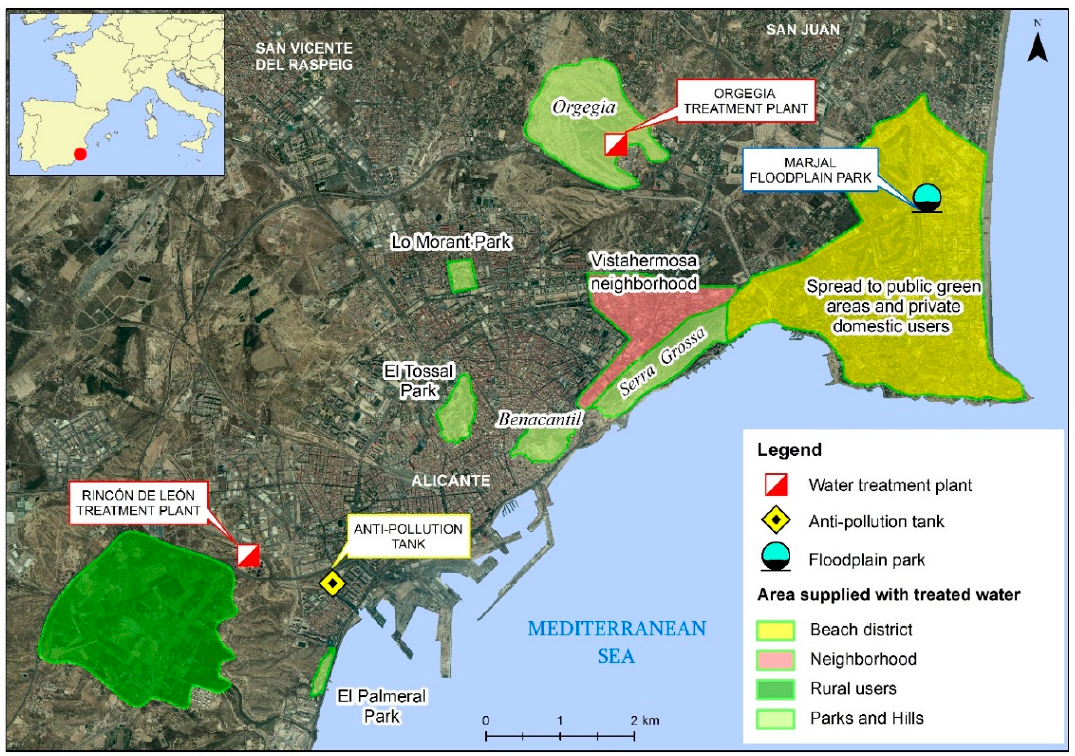
Figure 4. Location of the stormwater infrastructures and green areas watered with treated water. Own elaboration.